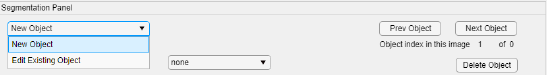
Figure 8. Segmentation panel: new object/existing object